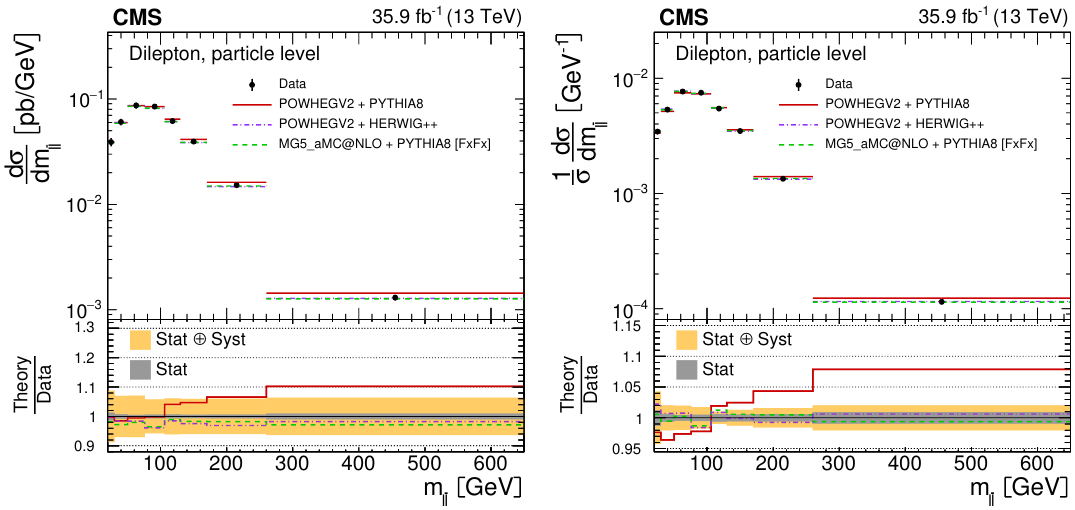
Figure 42 . The di(cid:11)erential tt production cross sections as a function of m space at the particle level are shown for the data (points) and the MC predictions (lines). The vertical lines on the points indicate the total uncertainty in the data. The left and right plots correspond to absolute and normalised measurements, respectively. The lower panel in each plot shows the ratios of the theoretical predictions to the data. The dark and light bands show the relative statistical and total uncertainties in the data, respectively.